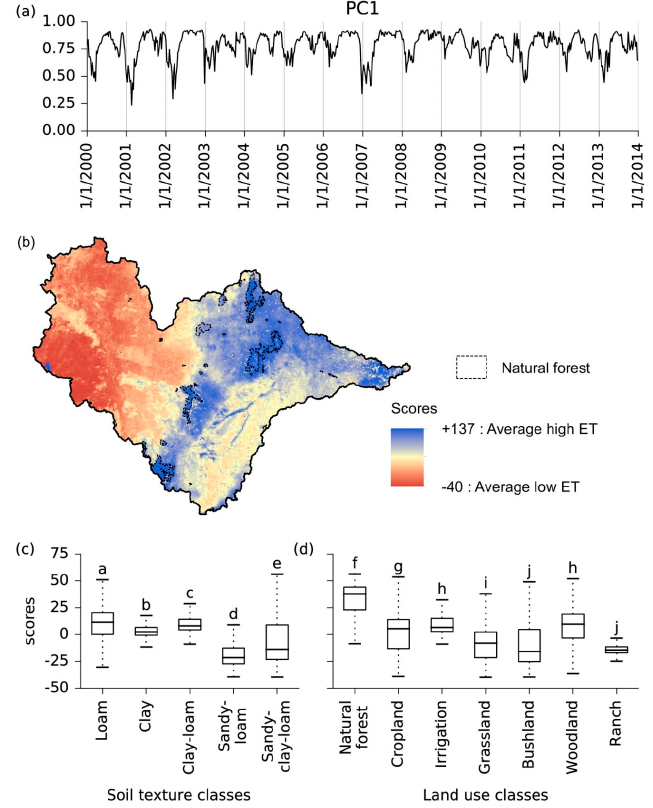
Figure 4. Time series of the loadings on the first principal component (PC1) ( a ). Map of the scores of PC1 and natural forest areas ( b ). Quartiles of the scores of PC1 for different soil texture ( c ) and land use ( d ) classes, similar score distributions at the 5% level of significance are marked with the same small letter.